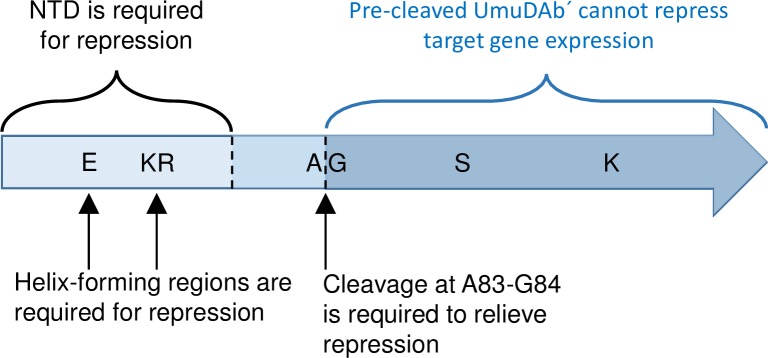
Model of amino acid motifs and domains required for UmuDAb-mediated gene repression and induction.Results of gene expression studies with defined umuDAb mutants revealed specific amino acid motifs and protein regions required for repression (NTD) and induction (CTD) of DNA damage-inducible genes. The roles of A83-G84, S119 and K156 were established for UmuDAb self-cleavage previously [20].